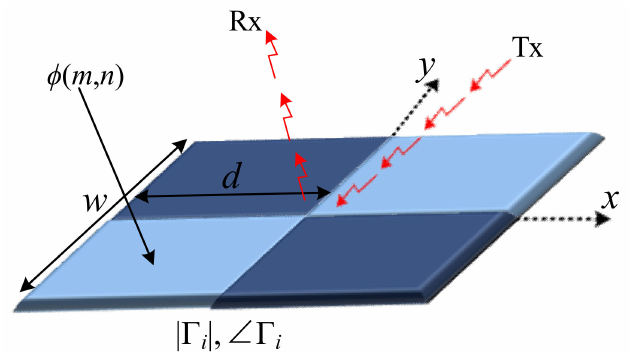
Figure 3. A simple configuration of a N × N